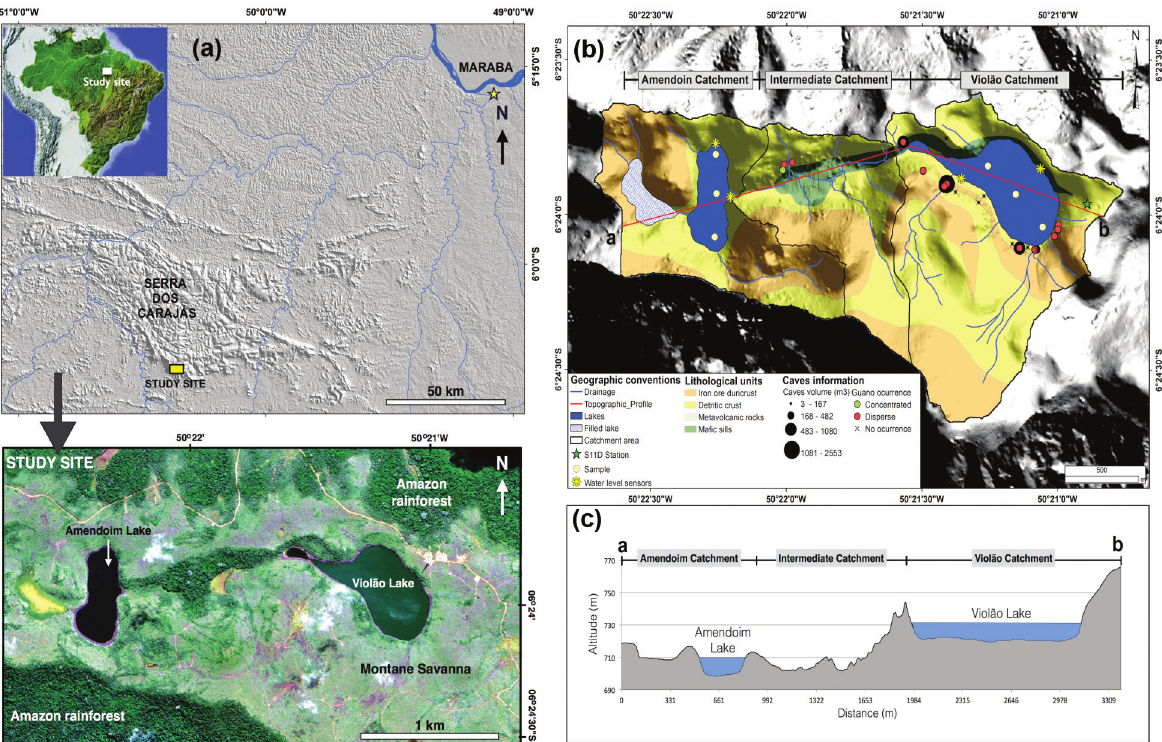
Figure 1 - a) Location of the study site and nearby cities. Worldview-2 image in color composite 5R3G1B, showing Amendoim and Violão lakes; b) Lithological and morphological characteristic of the catchment of Amendoim and Violão lakes, with location of caves as well as the position of the water level sensors, water sample points and S11D meteorological station; c) Topographic profile showing the difference of water level between Violão and Amendoim